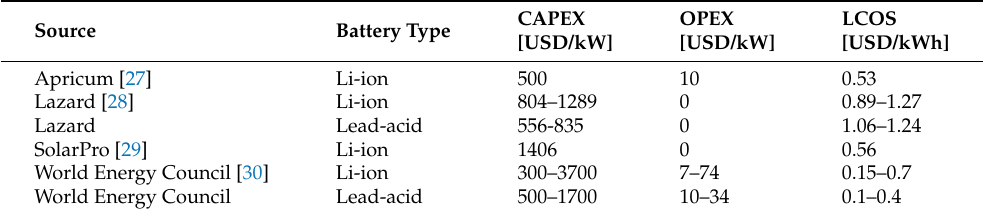
Table 1. LCOS for different battery